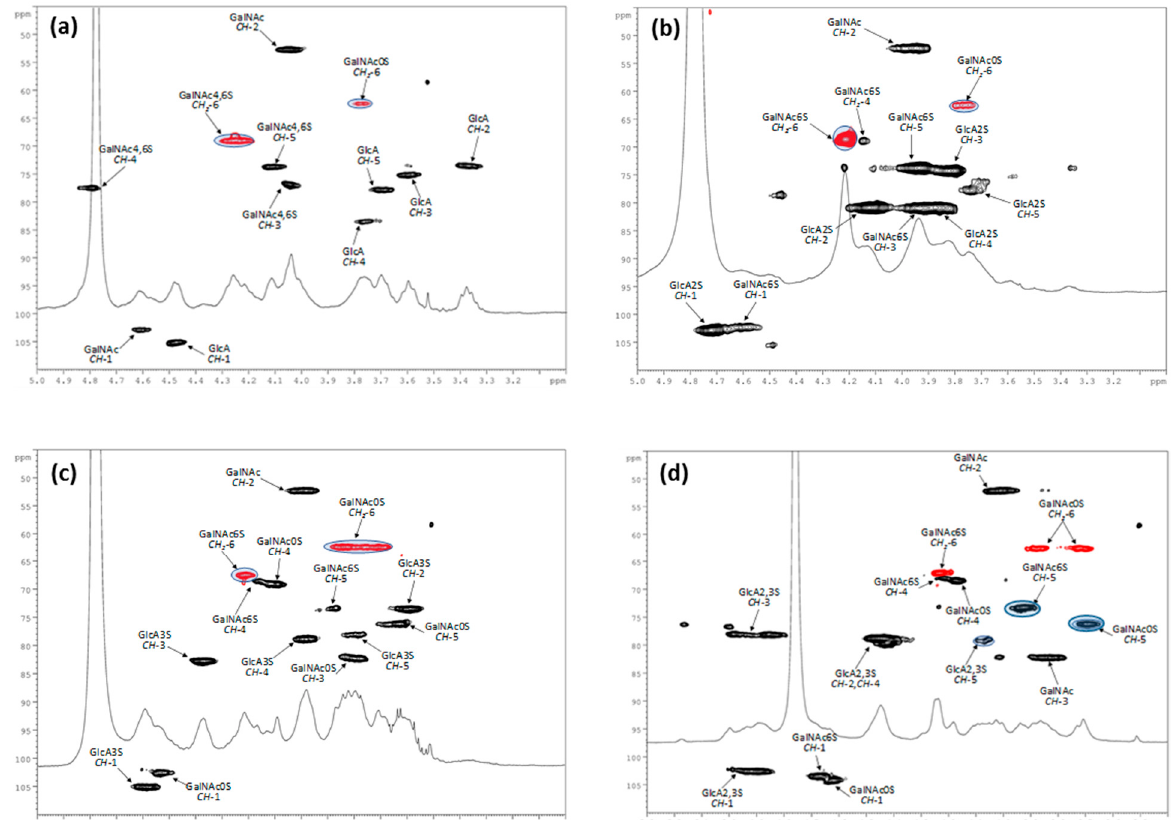
Figure 6. 1 H and DEPT-HSQC NMR spectra (400 MHz, D 2 O, 298 K, zoom) of CS-7 ( a ), CS-8 ( b ), CS-11 ( c ), and CS-12 ( d ). In Figure 6a, GalNAc is referred to both 4,6-disulfated and zero-sulfated GalNAc units. In Figures 6b–6d, GalNAc are referred to both 6-sulfated and zero-sulfated GalNAc units. Densities enclosed in the highlighted areas were integrated for disaccharide residue ratio estimation. For full 1 H and DEPT-HSQC NMR spectra, see Supporting Information (Figures S1–S4). Table 2. summarizes the disaccharide composition and sulfation degree of semi-syn- thetic CSs and CS-6. Table 2. Disaccharide composition and corresponding sulfation pattern of semi-synthetic polysaccharides. Polysaccharide Disaccharide Units